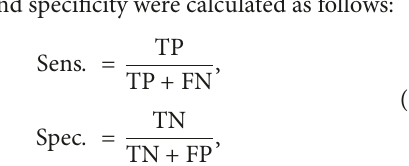
Table 2: Sensor sensitivity of the electronic tongue